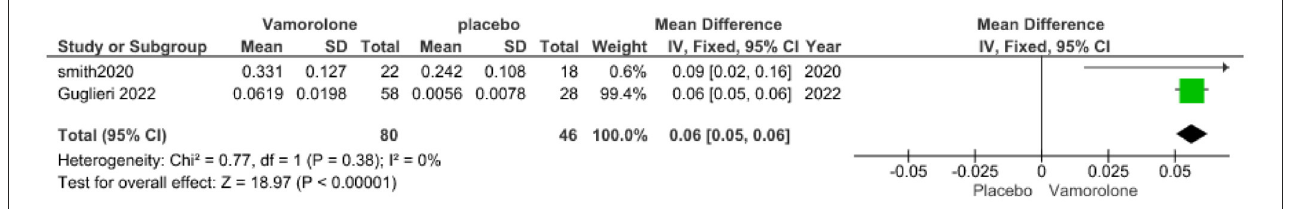
FIGURE4 TTCLIMB vamorolone vs. placebo.